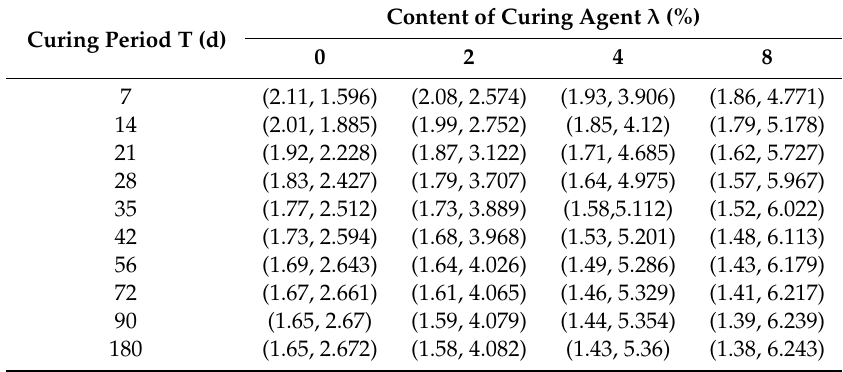
Table 8. The average equivalent aperture size ( x -axis) and compressive strength ( y -axis).